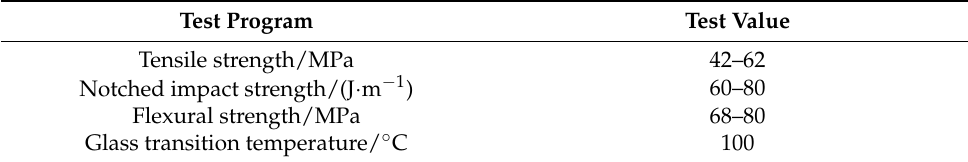
Table 2. Properties of ABS resin.